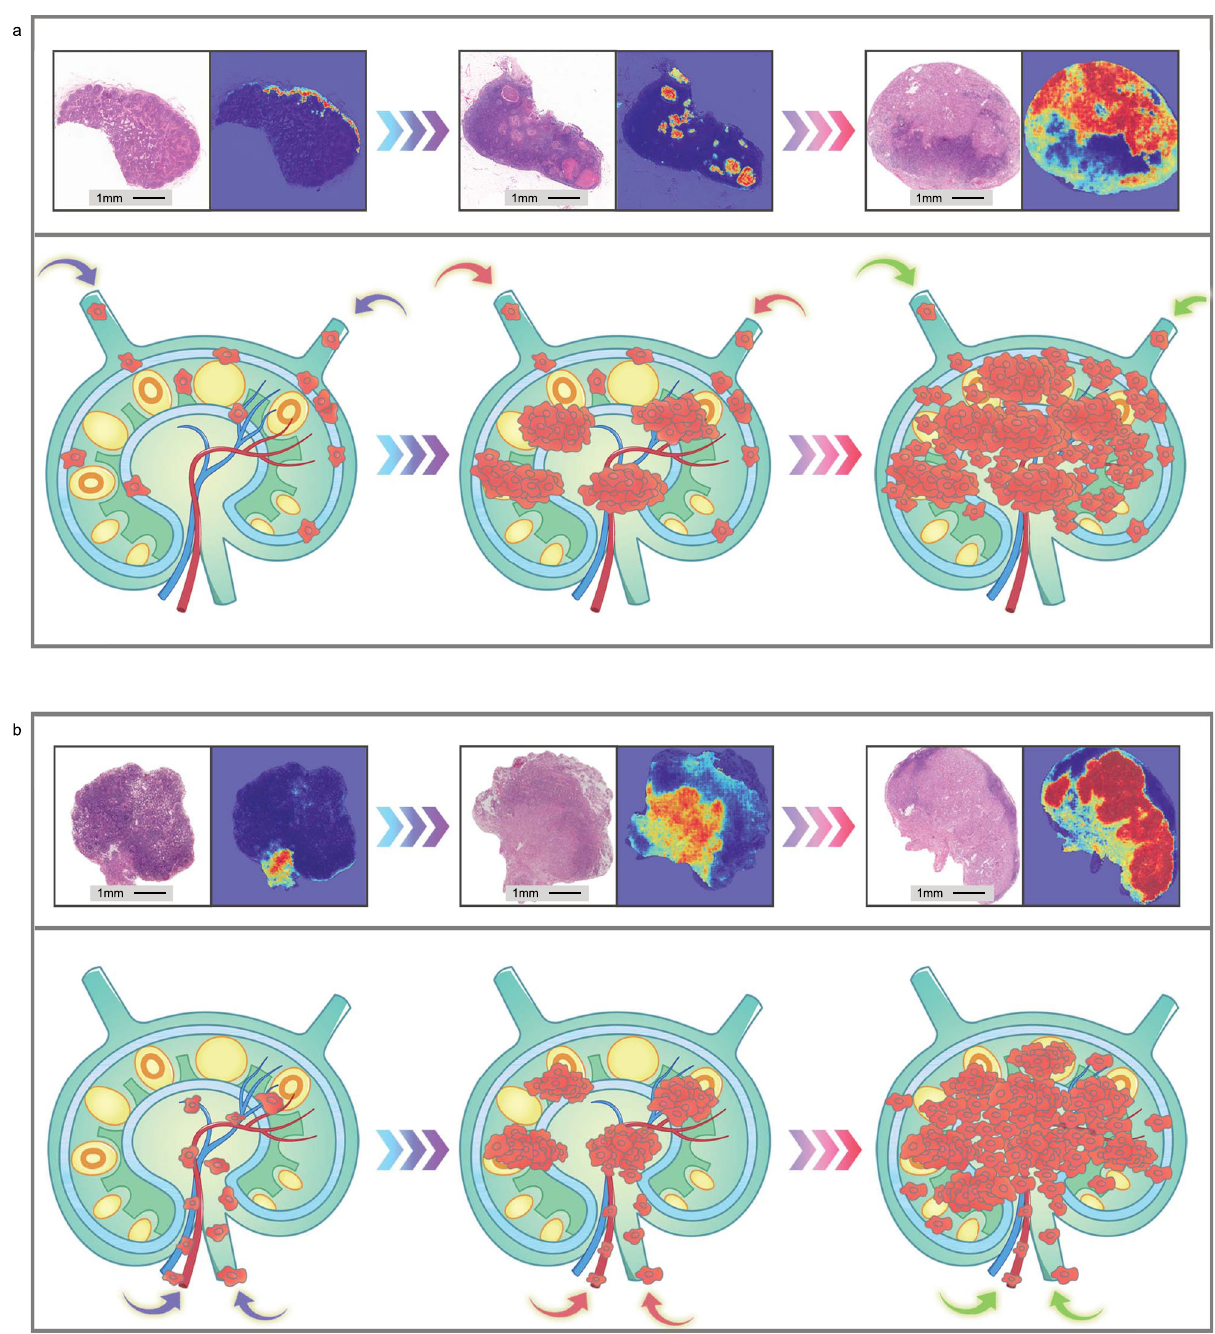
Fig. 6 Visualization of spatial information of metastatic lymph node displaying the potential process of tumor cells spreading in lymph nodes. a Representative images of HE slides and heatmaps of MLNs and diagrammatic sketch of MLNs showing that tumor cells invaded lymph nodes through afferent lymphatic vessels and gradually eroded the whole lymph nodes. b Representative images and heatmaps of MLNs and diagrammatic sketch of MLNs showing that tumor cells invaded lymph nodes through the hilum of lymph